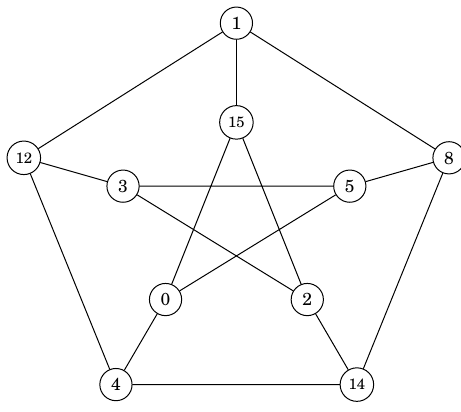
Figure 1: A graceful labeling.